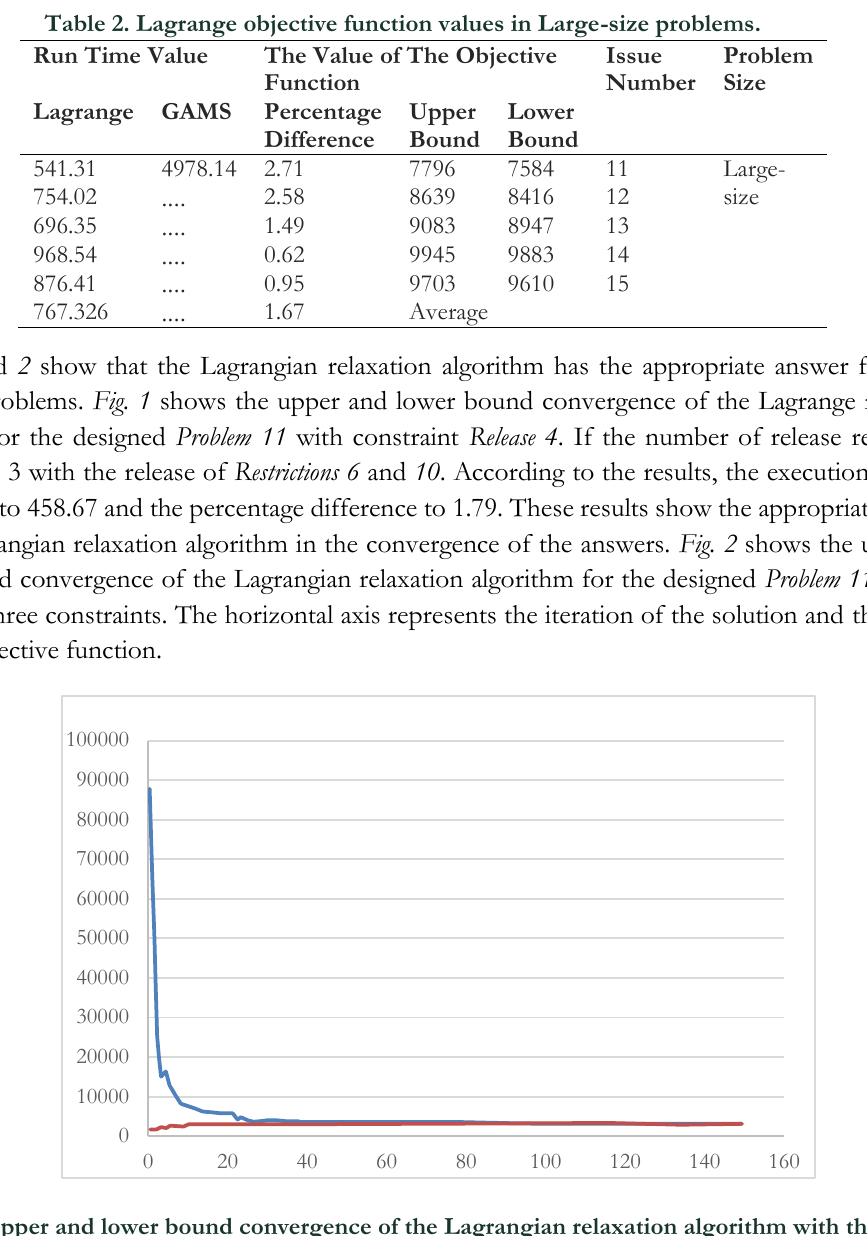
Fig. 1. Upper and lower bound convergence of the Lagrangian relaxation algorithm with the release of one